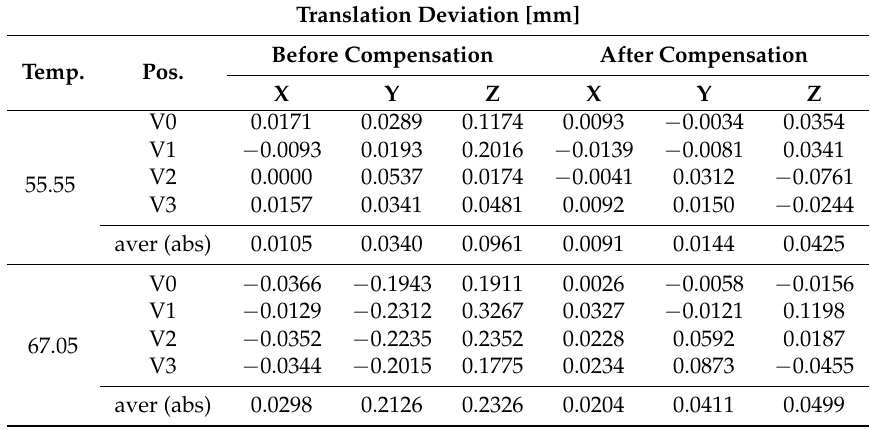
Figure 15. Average deviation of translations of artifact position, calculated for 11 different temperature values, relative to the artifact position calculated at the reference temperature along the X , Y , and Z axes, before (blue color) and after (orange color) compensation. Table 1. Translation deviation for calibration artifact positions V0–V3 before and after